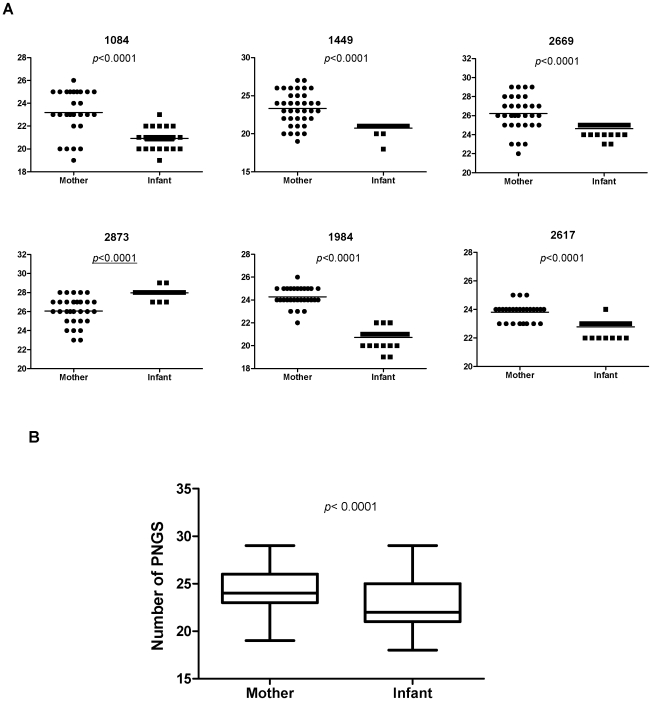
Comparison of PNGS in Env V1-V5 region between mother and infant variants.(A) Comparison of PNGS in Env V1-V5 region for each transmission pair. The P value for each comparison between the mother and infant are shown. The horizontal bars indicate the mean value for each individual. (B) Comparison of PNGS in Env V1-V5 region of the aggregate sequences from mothers and infants. The P value for the comparison between the mother and infant is shown. The box and whiskers plot denotes the median, minimum and maximum values.